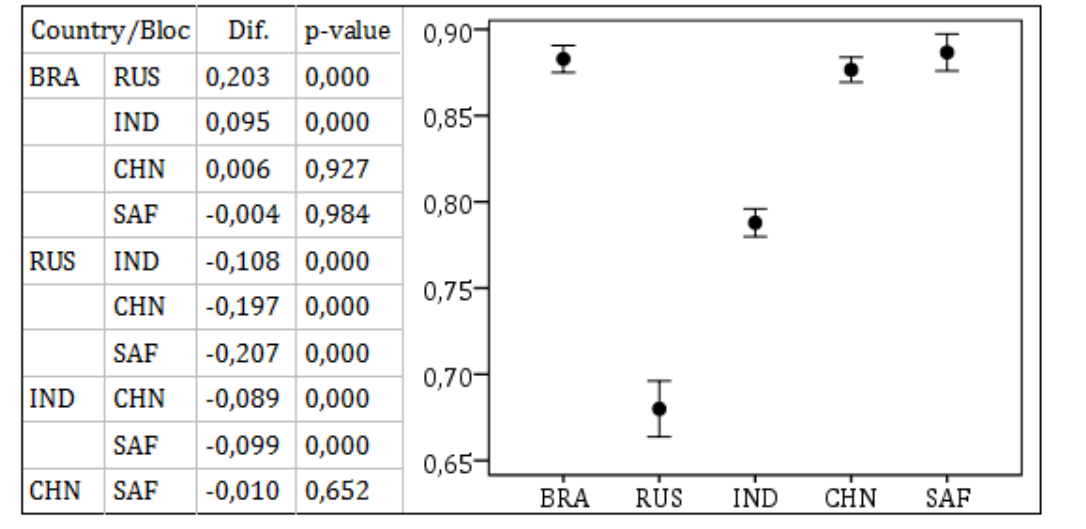
Figure 1. Multiple comparisons of regional affinity between the BRICS